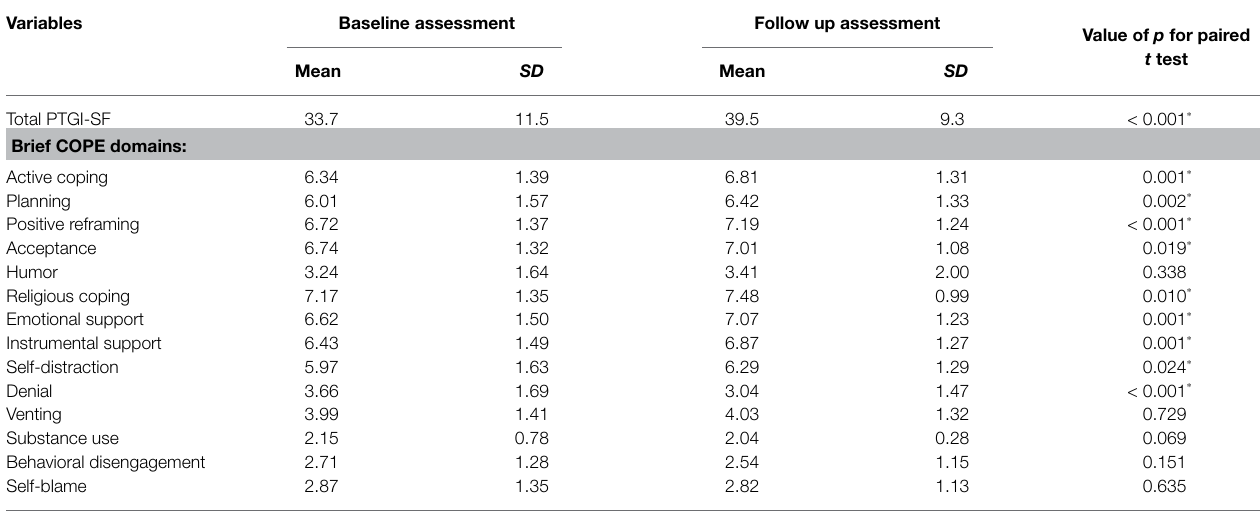
TABLE 2 | Mean total Posttraumatic Growth Inventory-Short Form (PTGI-SF) and Brief Coping Orientation to Problems Experienced Inventory (Brief COPE) domain scores during baseline and follow up assessment among the respondents. Variables Baseline